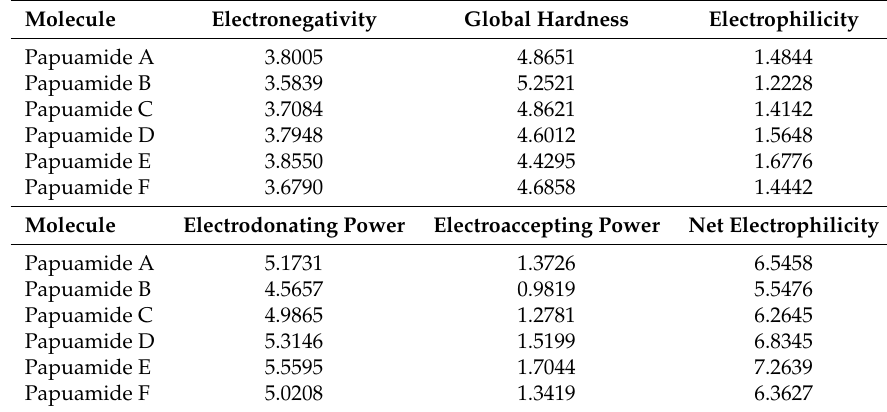
Table 2. Global reactivity descriptors of Papuamides A–F, calculated with the MN12SX density functional with the Def2TZVP basis set and the SMD solvation model using water as the solvent.